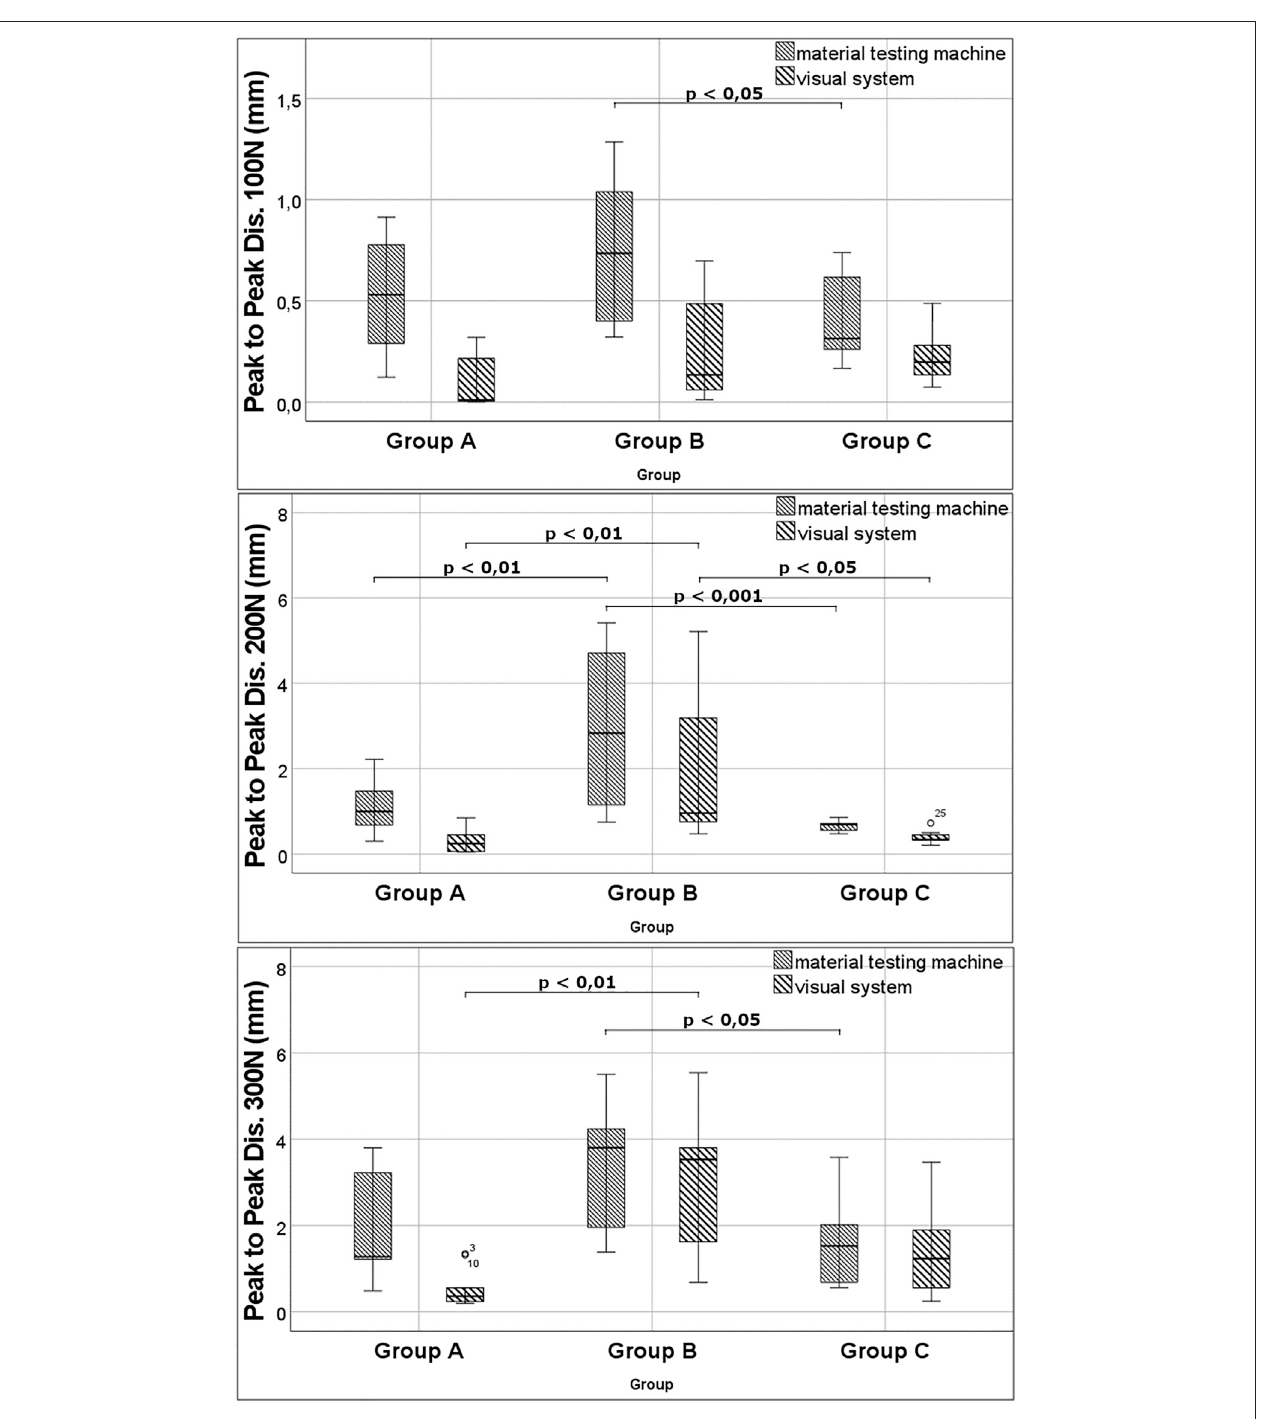
FIGURE 4 | Results for peak-to-peak displacement at different load